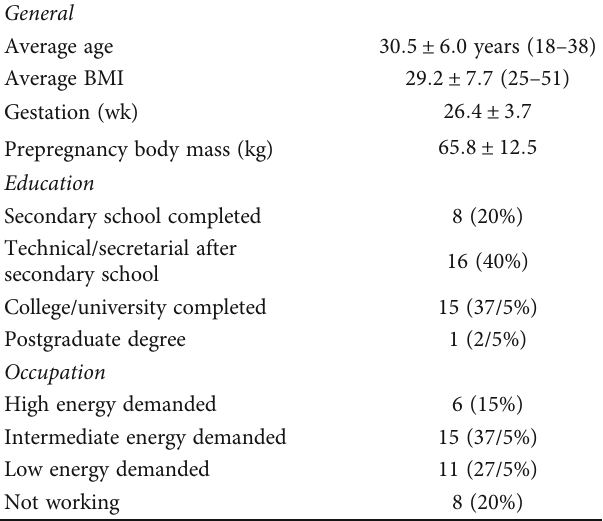
Table 1: Participant characteristics ( n = 40